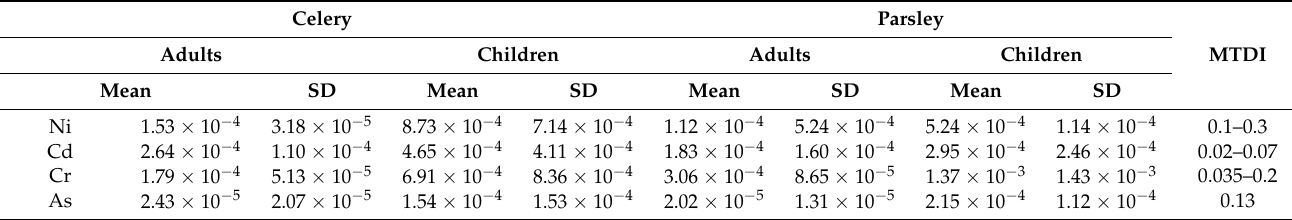
Table 1. Estimated daily intake—EDI (mg/kg/bw) of Ni, Cd, Cr, and As in celery and parsley. Values are presented as the mean ( n = 21) ± standard deviation (SD) and compared with the tolerable daily intake (MTDI) mg/kg. Celery Parsley MTDIAdults Children Adults